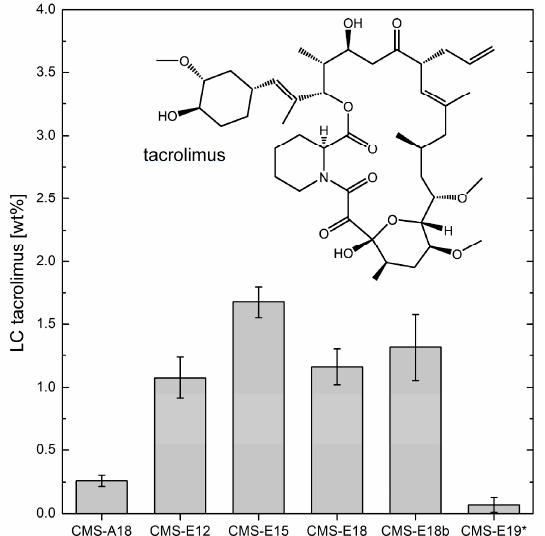
Figure 4. Loading capacities of tacrolimus in the examined carrier systems vs. the T m values of the inner shell. Encapsulation was done with the film-uptake method, n = 3, error bars indicate standard deviation, * performed at 60 °C.